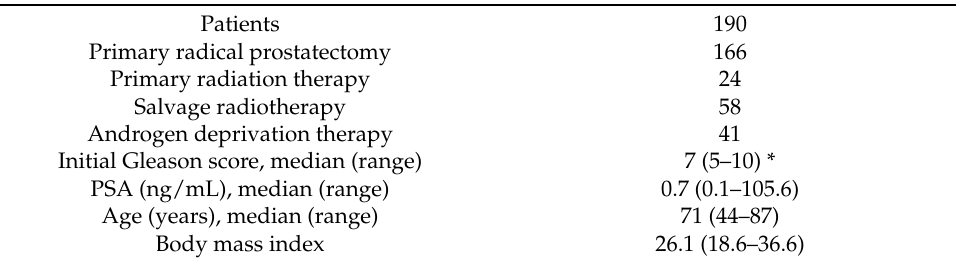
Table 1. Patient